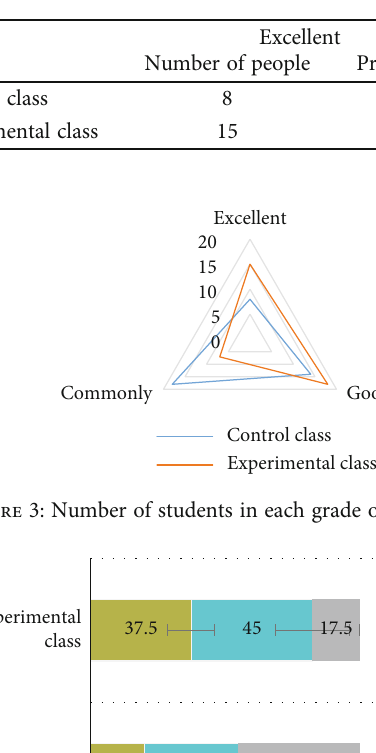
Table 2: Overall performance